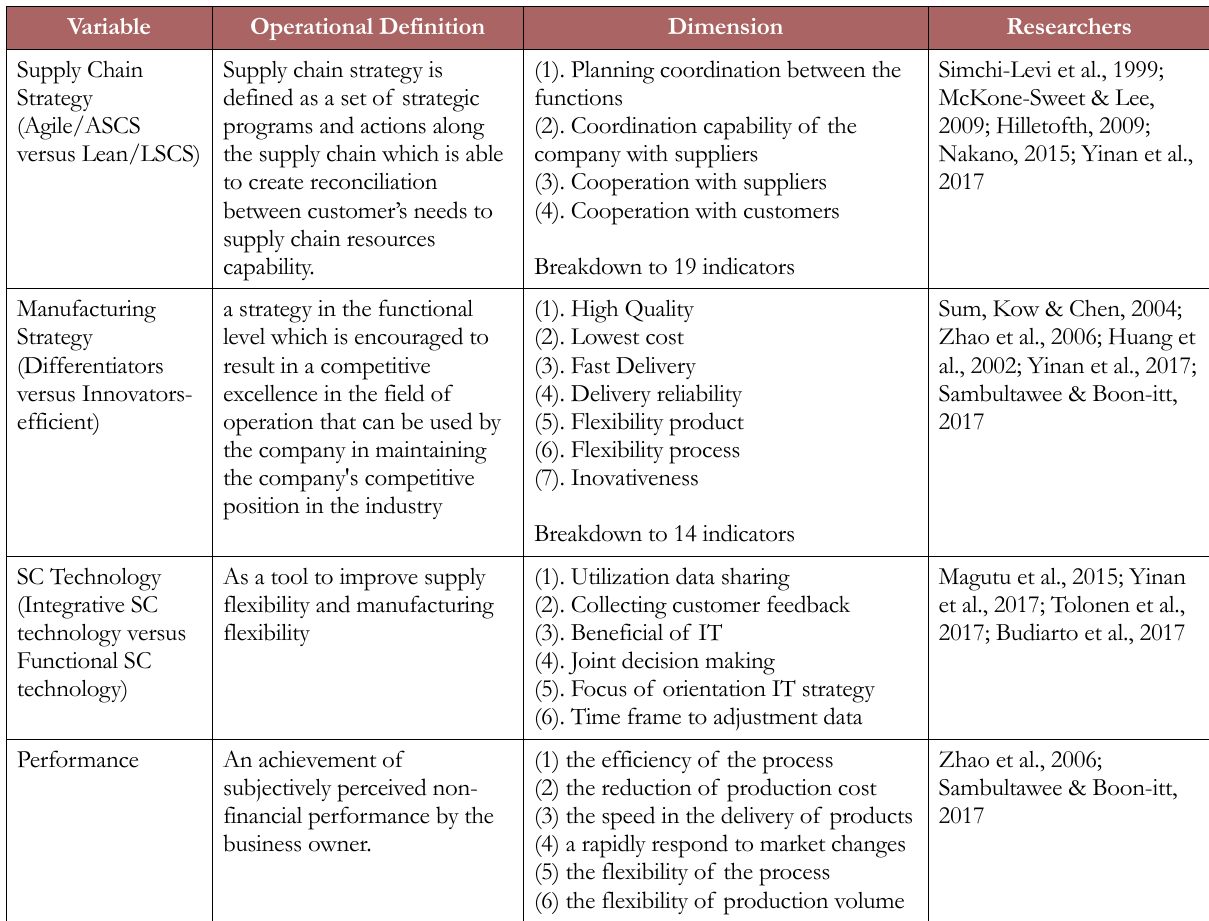
Table 3. The definition of an operational